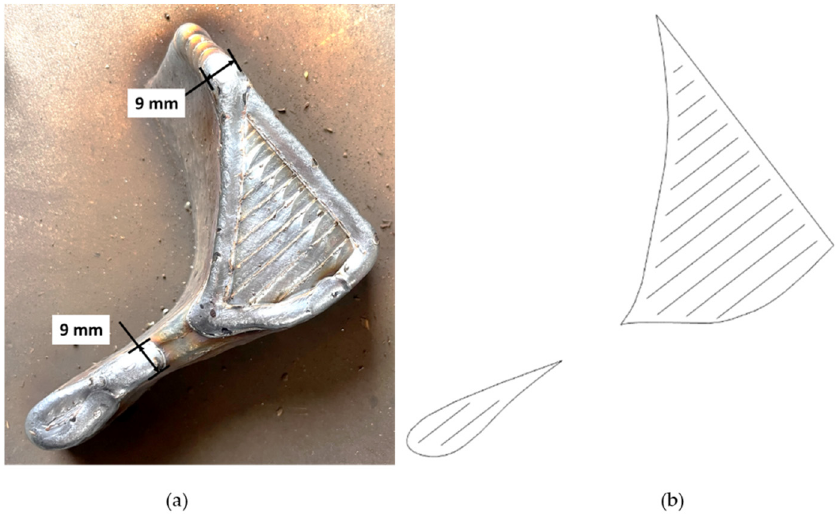
Figure 12. Criterion of minimum wall thickness ( a ) obtained wall thickness ( b ) planned robot path.